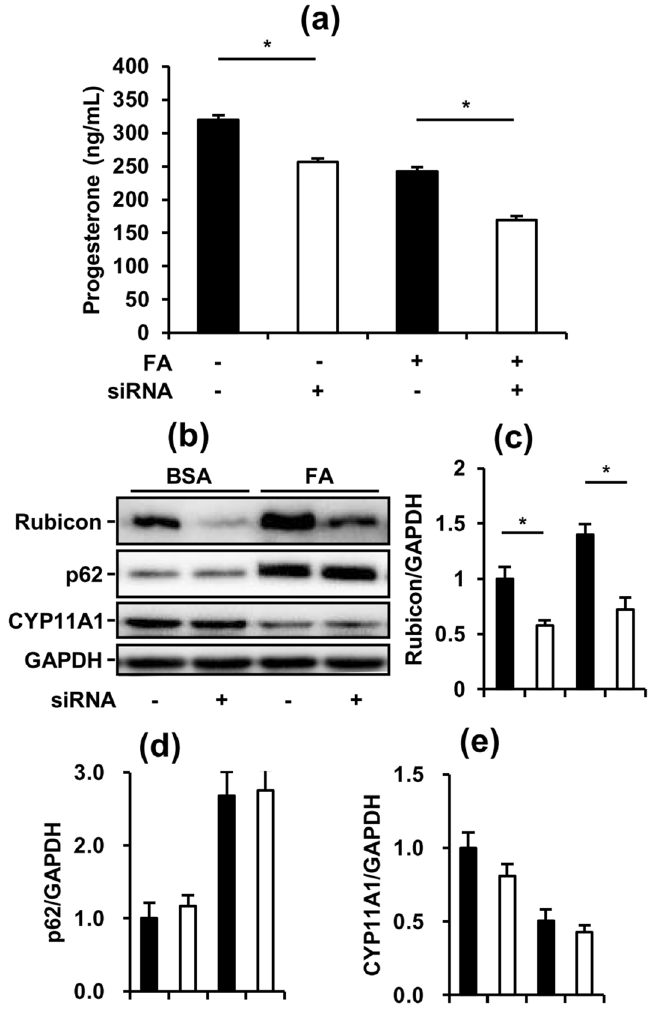
Figure 7. Rubicon plays an indispensable role in maintaining and regulating the steroidogenesis of MA-10 cells, independent of the inhibition of late-stage autophagy. To further check the effects of late-stage autophagy inhibition on FA-suppressed steroidogenesis, we applied siRNAs to knock down Rubicon. After transfection with or without 10 nM Rubcn siRNAs for 72 h and treatment with 1% BSA or 1200 µM fatty acids (0.6 mM PA mixed with 0.6 mM OA) in the last 48 h, the conditioned medium and cell lysates from cultured MA-10 cells were collected for further analysis. ( a ) Progesterone levels in condition medium from the assigned groups of MA-10 cells. ( b ) Representative blots of autophagy and steroidogenesis markers in cultured MA-10 cells. ( c ), ( d ), ( e ) Quantifications normalized by GAPDH are shown as the means ± SEM (n = 3). *P <